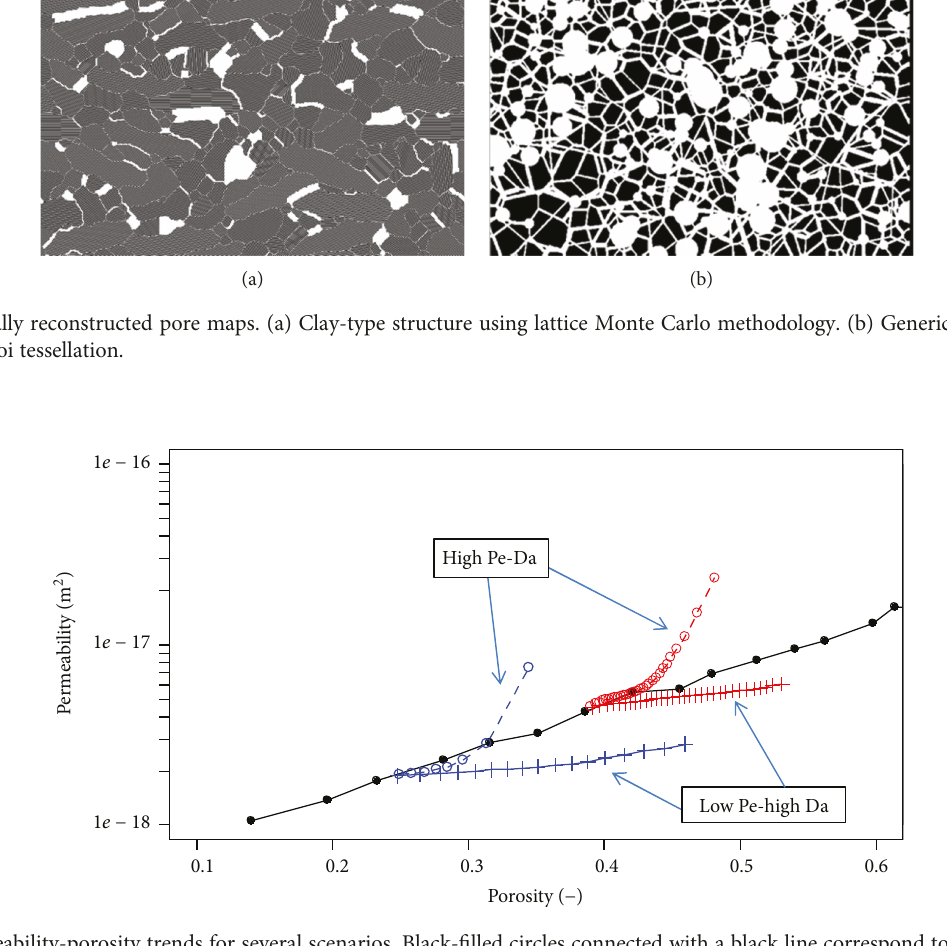
Figure 3: Permeability-porosity trends for several scenarios. Black- fi lled circles connected with a black line correspond to the permeability versus the porosity of the computer-generated unreacted samples. Blue ( ε = 0 25 ) and red ( ε = 0 39 ) curves correspond to the distinct permeability-porosity temporal evolution paths under di ff erent reactive transport conditions (circles: high Pe-high Da, crosses: moderate Pe-high